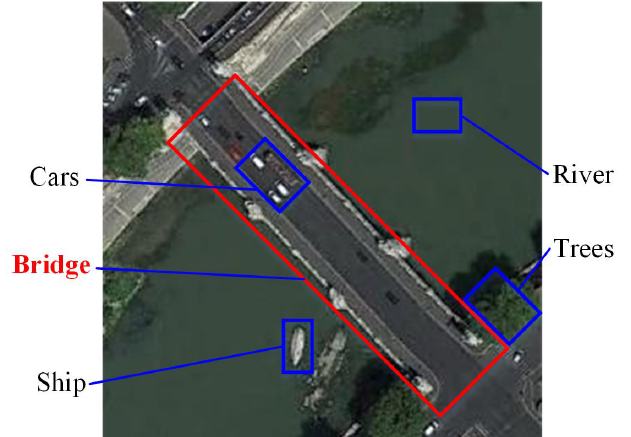
Figure 1. The characteristics of a remote sensing scene image. A remote sensing scene consists of many types of land cover units. However, to classify this scene, we only need to pay more attention to the key regions, i.e., bridge, while other regions can be regarded as